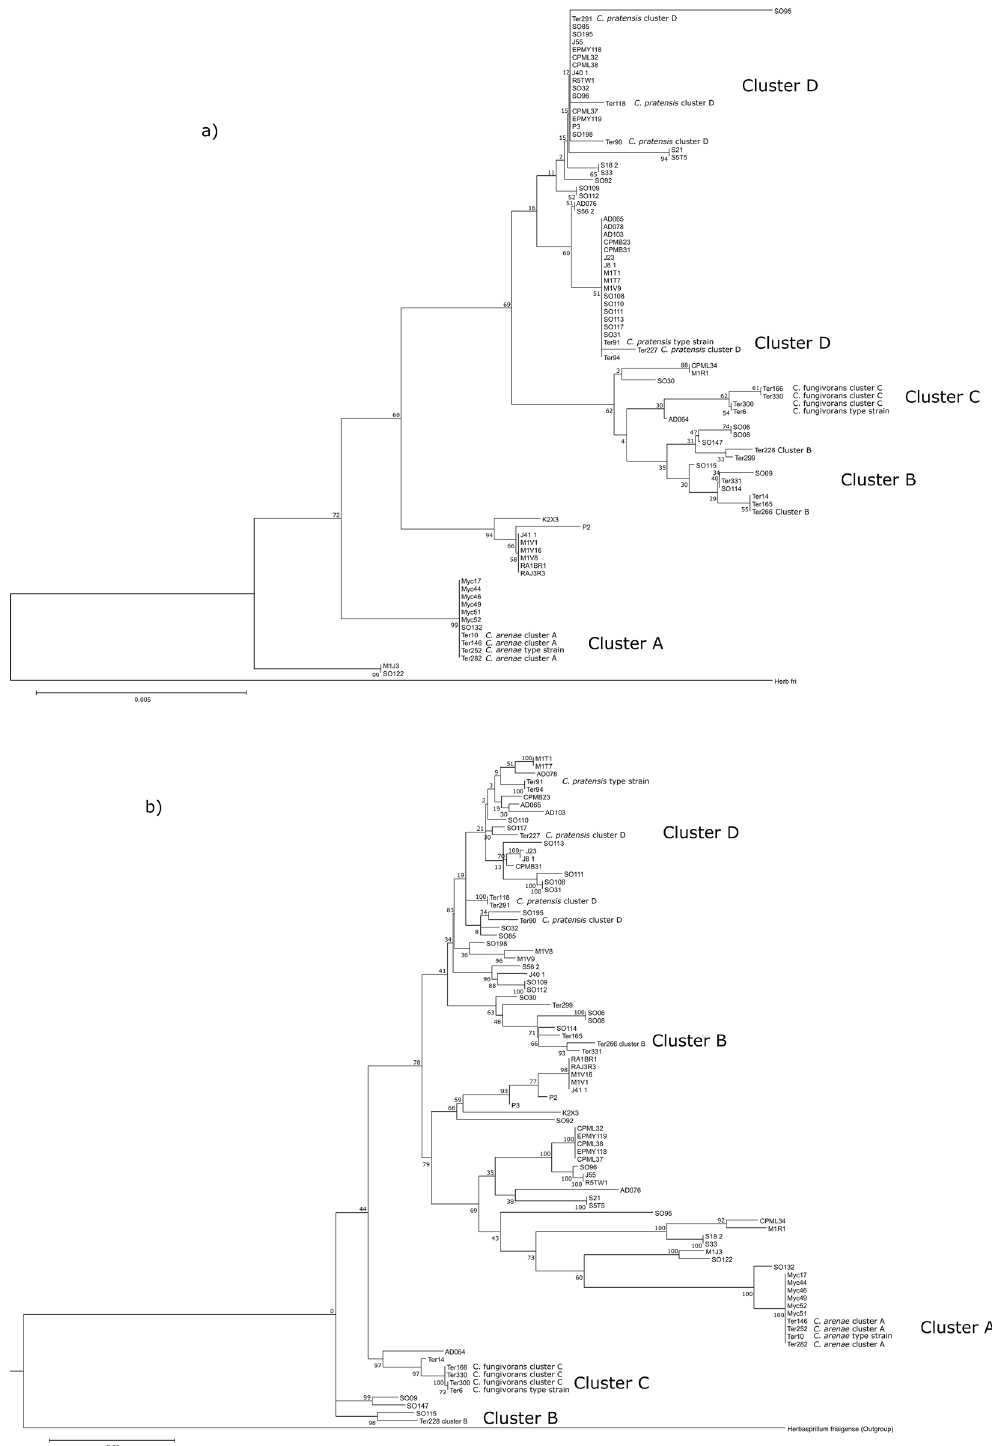
Fig 1. Comparison single gene derived phylogeny a) (16s) and concatenated gene derived phylogeny b) (16s, rpoB, and gyrB) Bacterial strain assignment to clusters as suggested by Hoppener-Ogawa, de Boer [38] is indicated. The trees were tested with 100 bootstraps and the respective support values are indicated at the tree nodes.